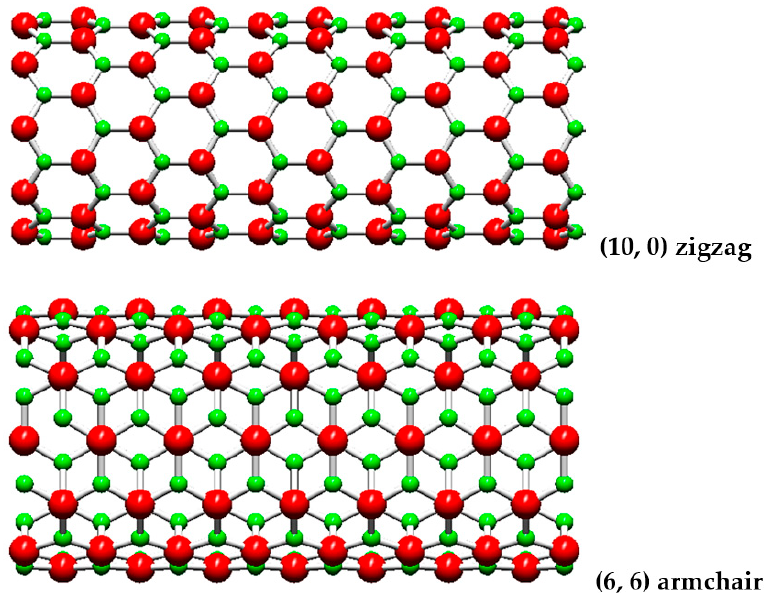
Figure 2. Configurations of (10, 0) zigzag and (6, 6) armchair SWSiCNTs, obtained using the software Nanotube Modeler©. The Si atoms are shown in red; the C atoms in green.